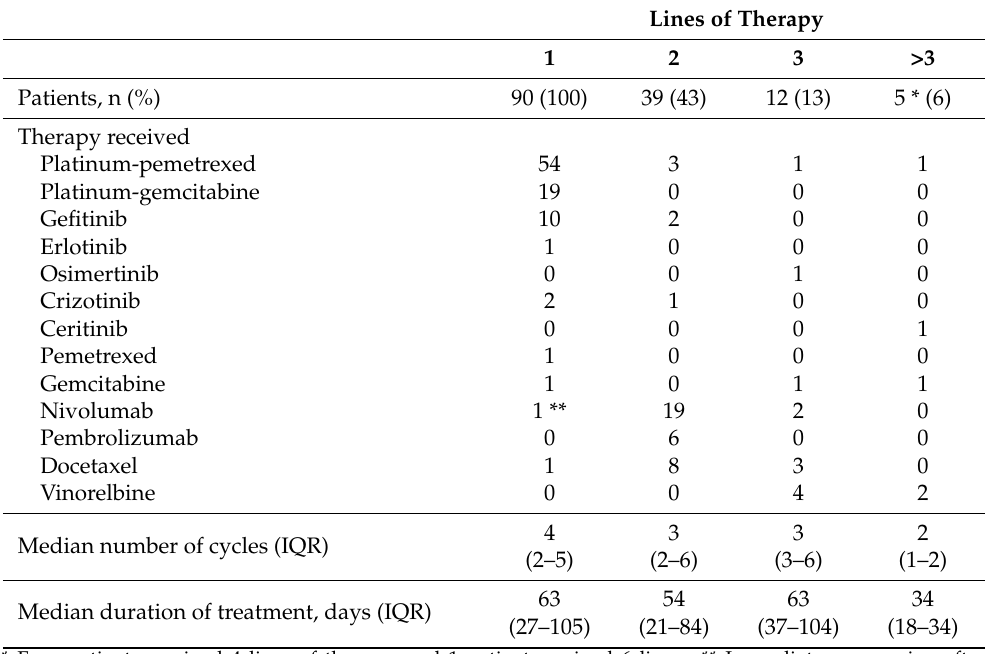
Table 2. Lines and duration of systemic therapy.